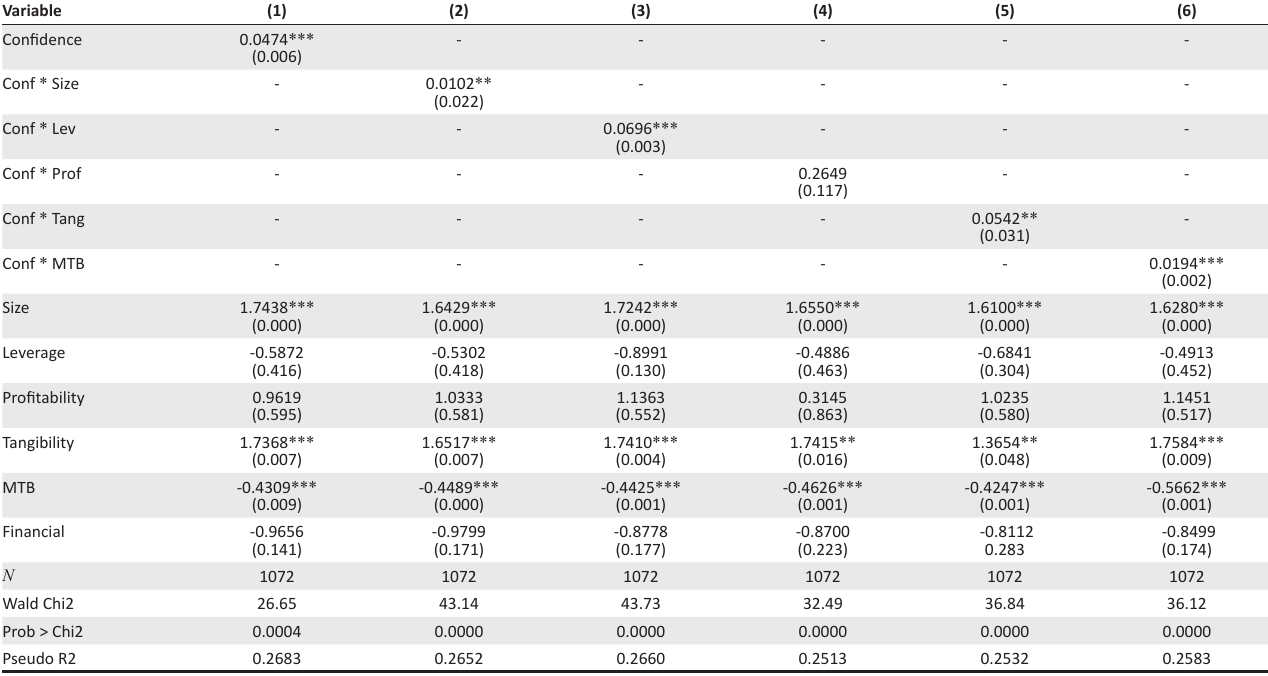
TABLE 4: Regression results for the factors influencing the likelihood of issuing debt.